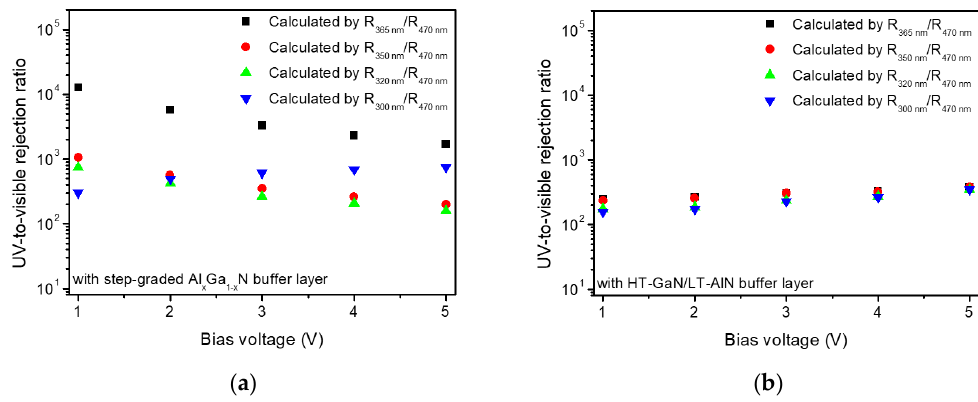
Figure 5. UV-to-visible rejection ratio of GaN MSM UV photodetectors with ( a ) the step-graded Al x Ga 1 − x N buffer layer and ( b ) HT-GaN/LT-AlN buffer layer, showing significantly enhanced UV-to-visible rejection ratio of the GaN MSM UV photodetector with the step-graded Al x Ga 1 − x N buffer layer at 365-nm wavelength.